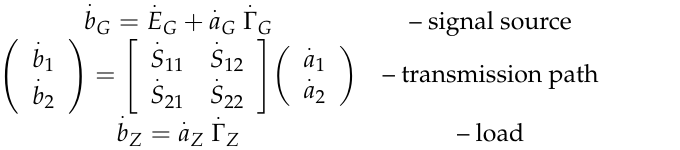
Figure 1. Schematic diagram of measuring system for electrical length of the transmission path. Each of the n-terminal networks of the system is assumed to be linear and described